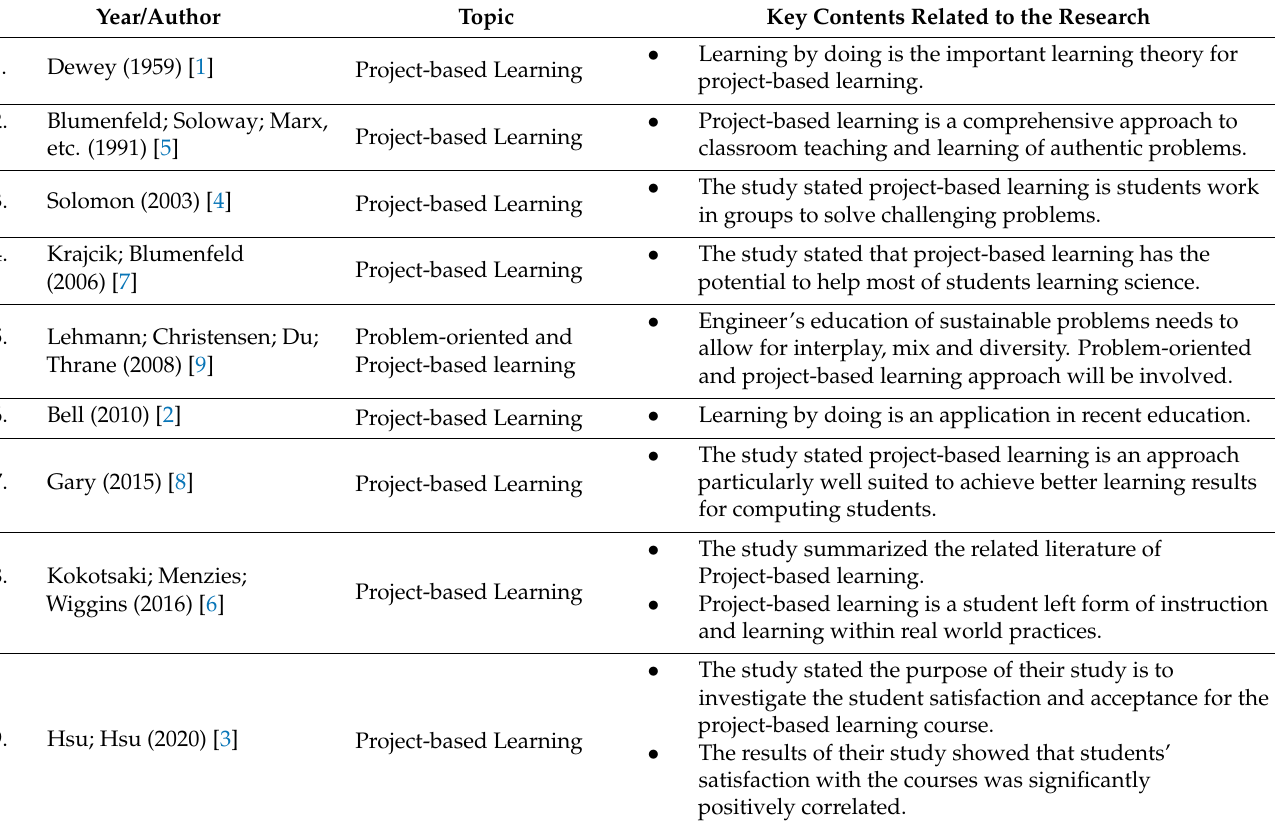
Table 1. Related literature of